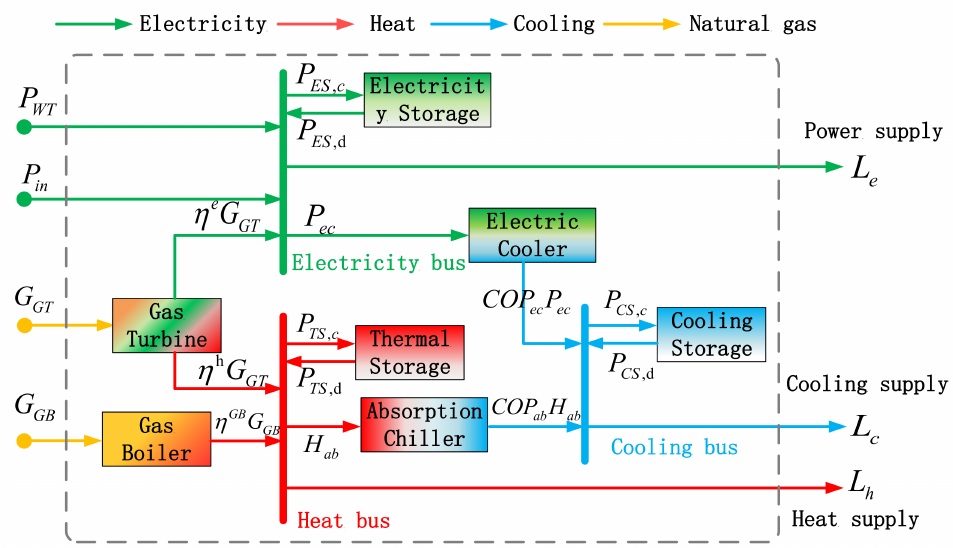
Figure 2. Energy flow in a typical